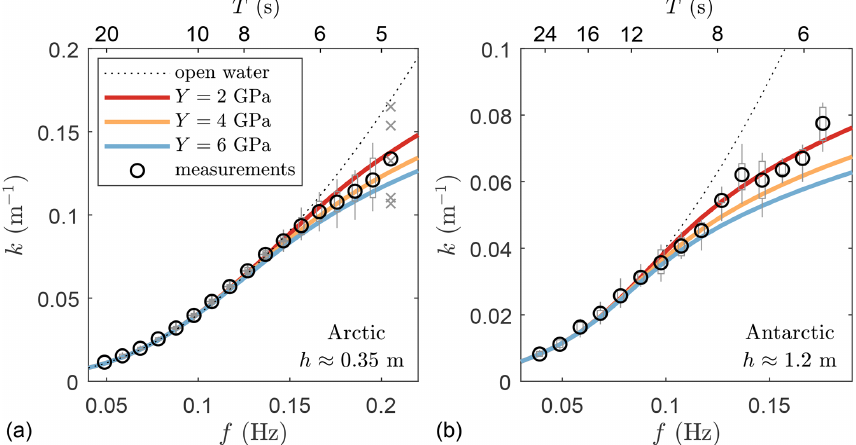
Figure 2. Mean values of the estimated wavenumber k in landfast ice based on experimental observations (circle) in (a) the Arctic and (b) the Antarctic. Solutions of the dispersion relation following an elastic thin plate are provided in color. Note that for the Arctic experiment there are only a limited number of observations available at f = 0 . 21Hz (cross). In (a) and (b) , boxes identify the 25th and 75th percentiles, the vertical bars identify the 9th and 91st percentiles, and circles identify the bin-averaged values.